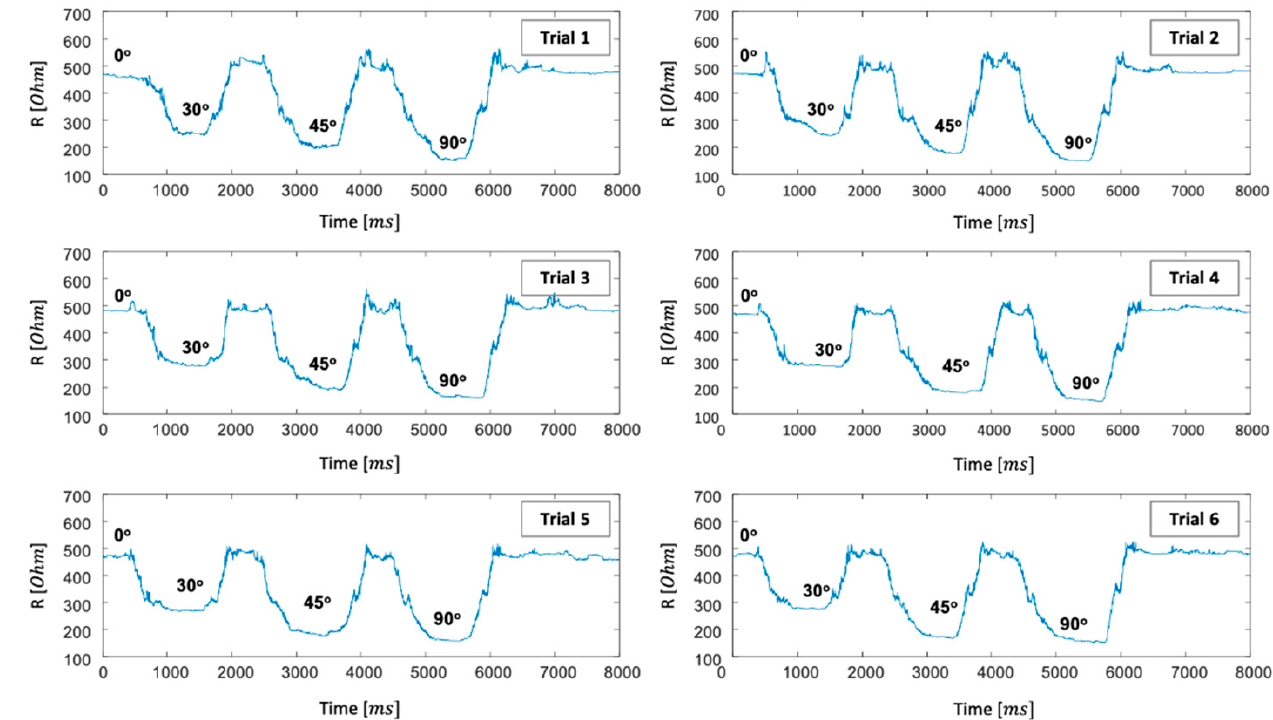
Figure 8. Electrical resistance variations according to the amplitudes of the index finger movements.